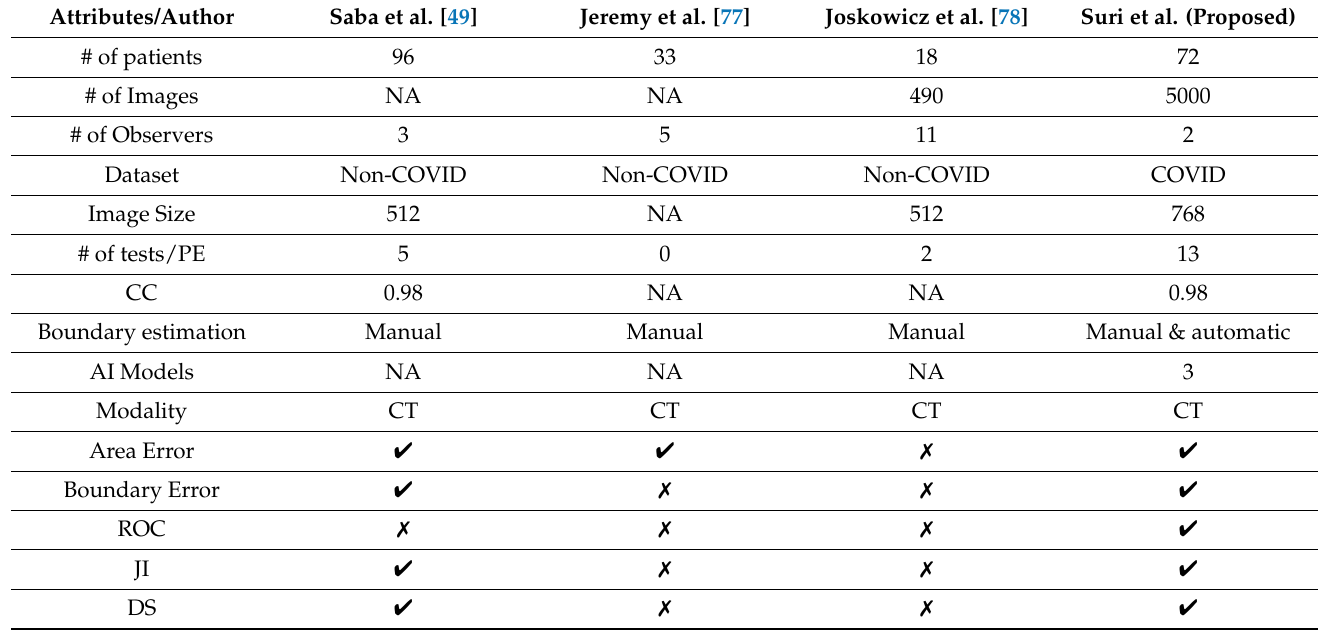
Table 7. Benchmarking